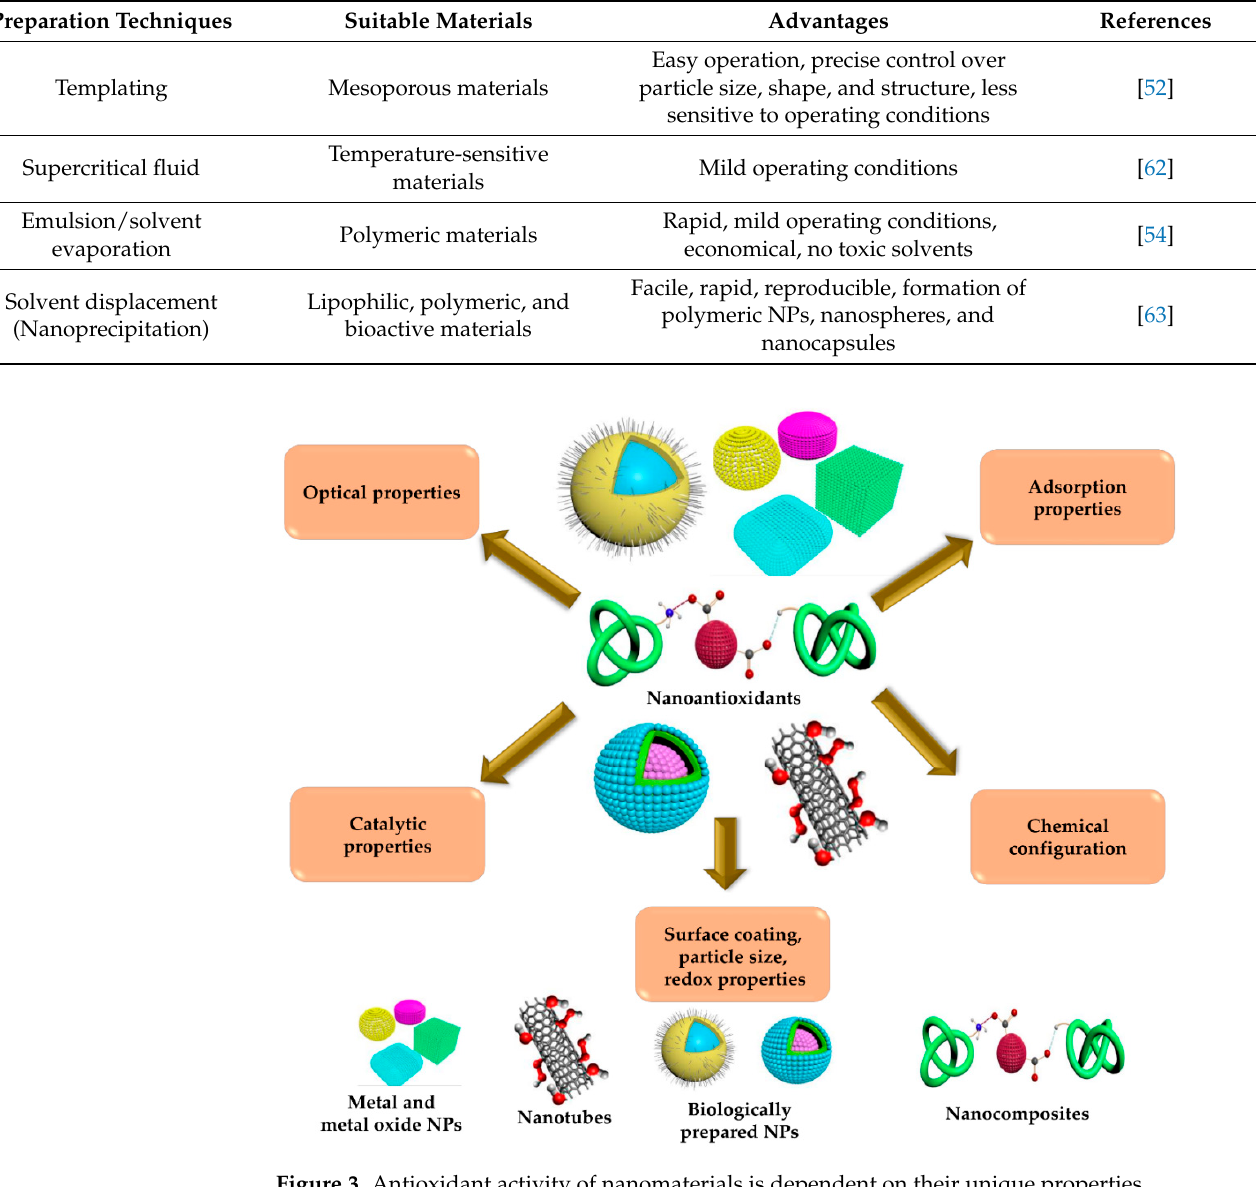
Figure 3. Antioxidant activity of nanomaterials is dependent on their unique properties.